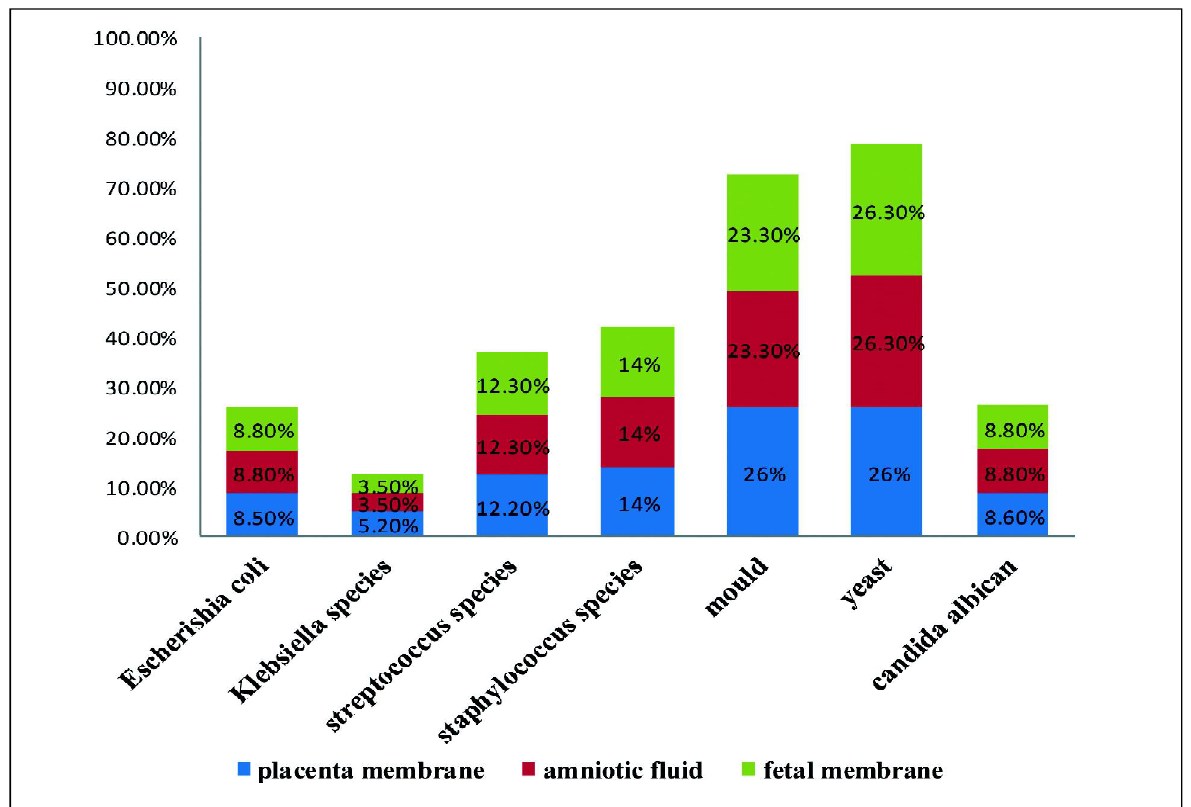
Figure 2: The most dominant microorganisms infection in women with